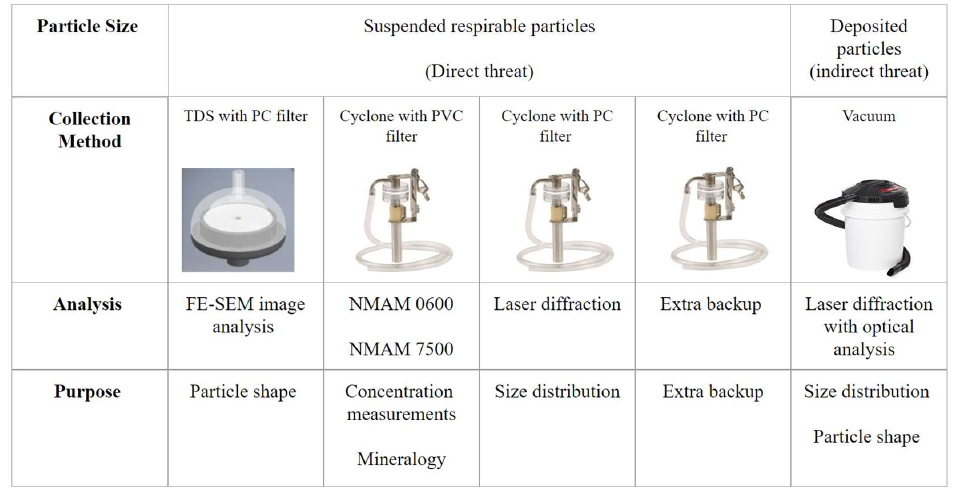
Figure 5. Representation of the instruments used for sampling, analyses performed, and character- ization output obtained for the various particles collected.